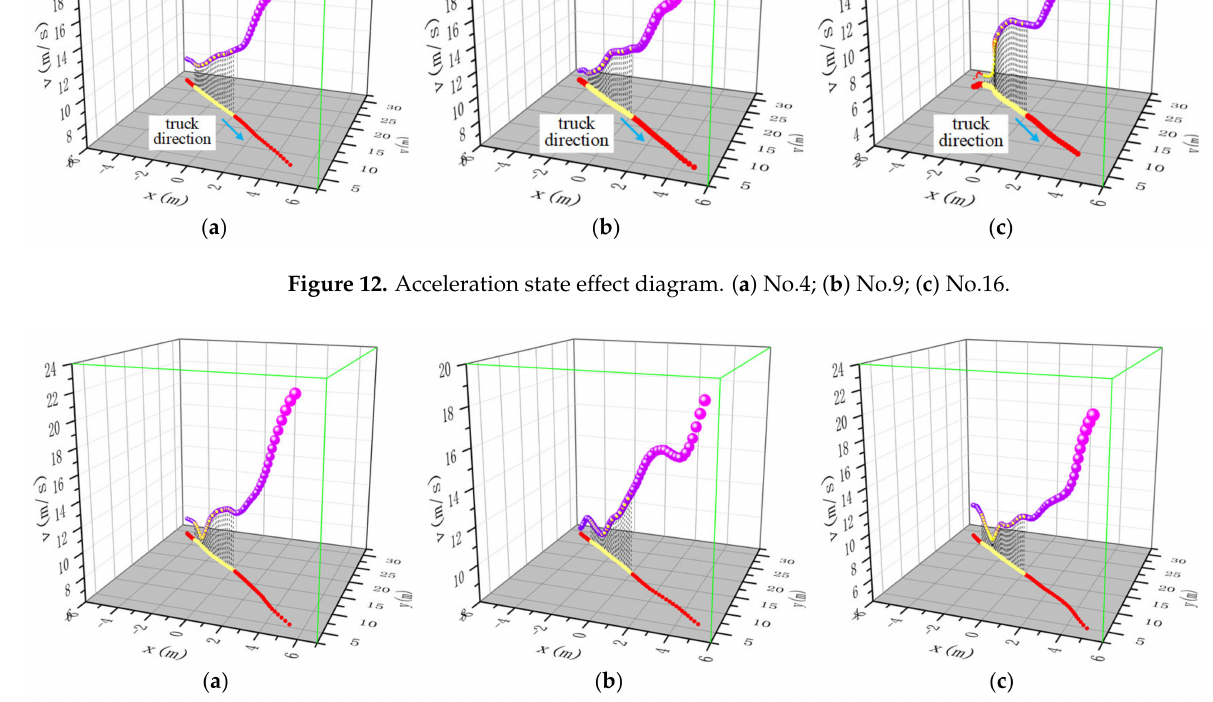
Figure 13. First deceleration—then acceleration state effect diagram. ( a ) No.6; ( b ) No.13; ( c ) No.17.